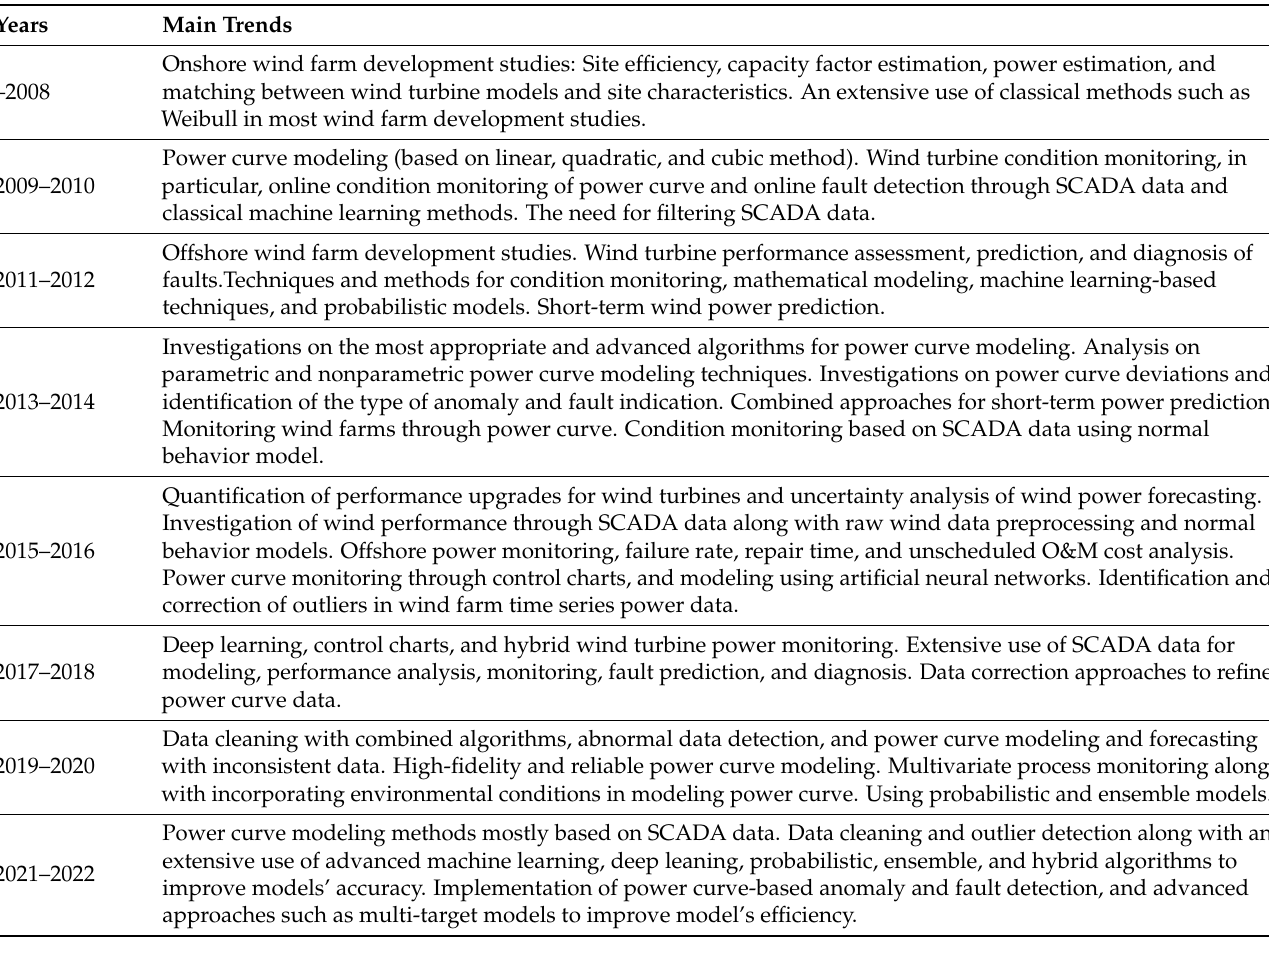
Table 9. Main trends over the